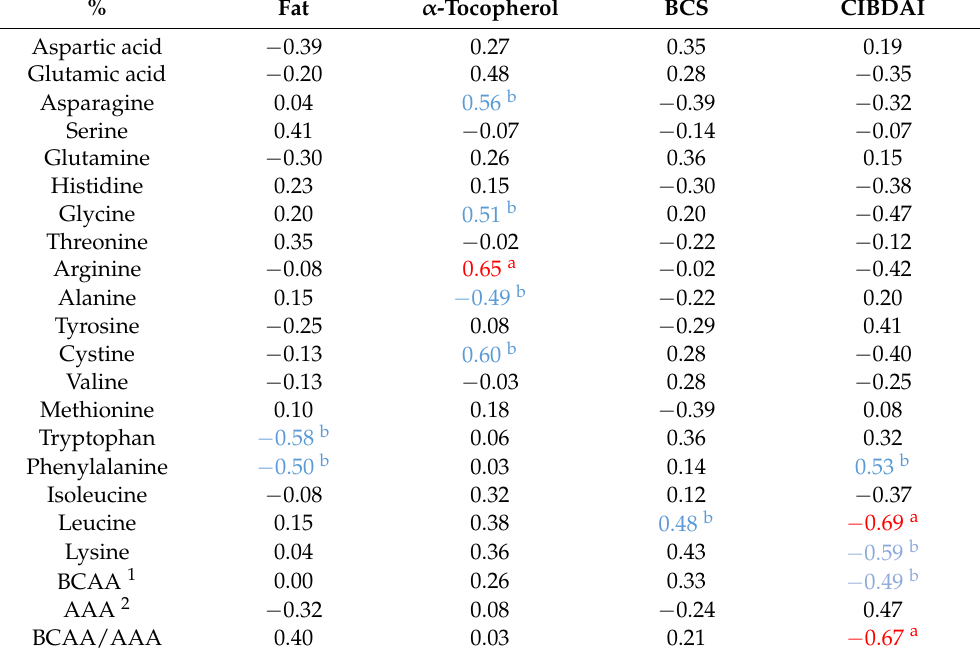
Table 2. Correlation coefficients between plasma amino acids proportions and plasma fat, plasma α -tocopherol, body condition score (BCS), and CIBDAI (canine inflammatory bowel disease activity index).